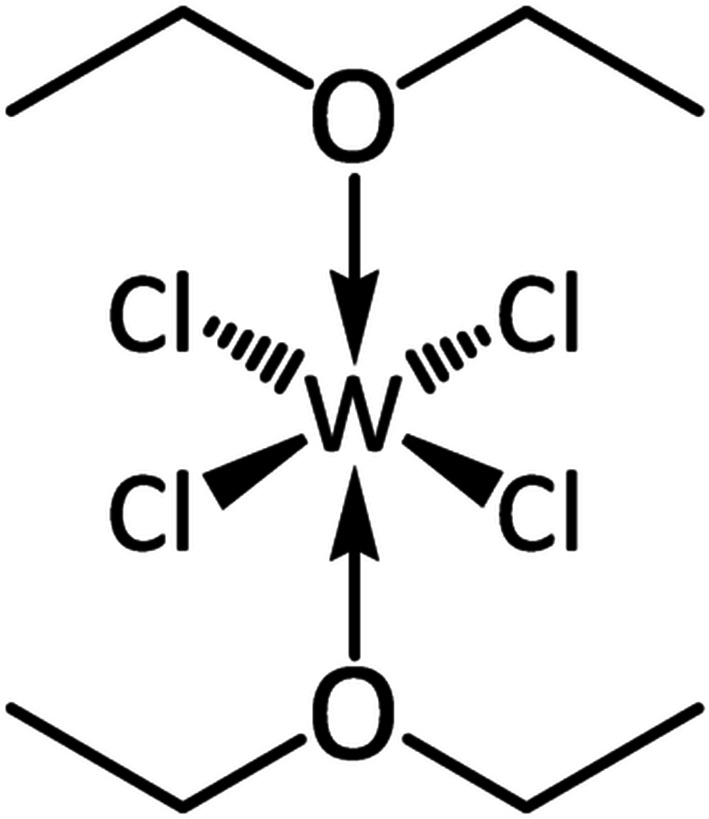
Tungsten tetra­chloride bis­(di­ethyl etherate), WCl4(Et2O)2.